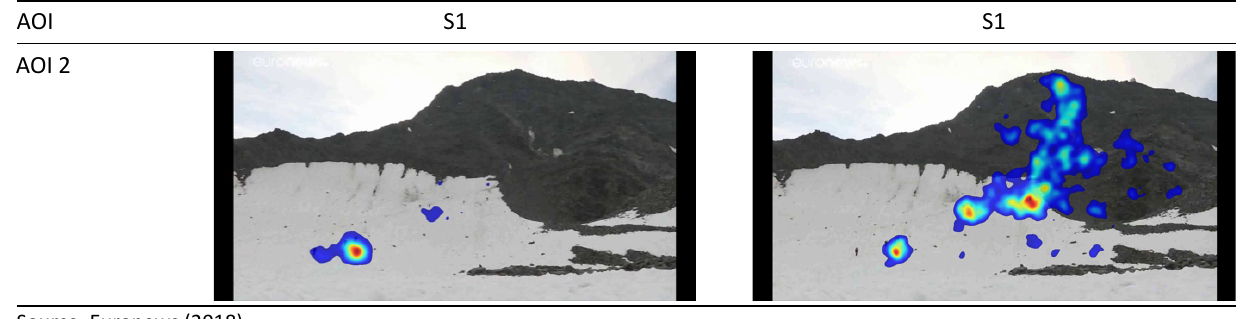
Table 5. Heat maps of the stimuli. AOI S1 S1 AOI